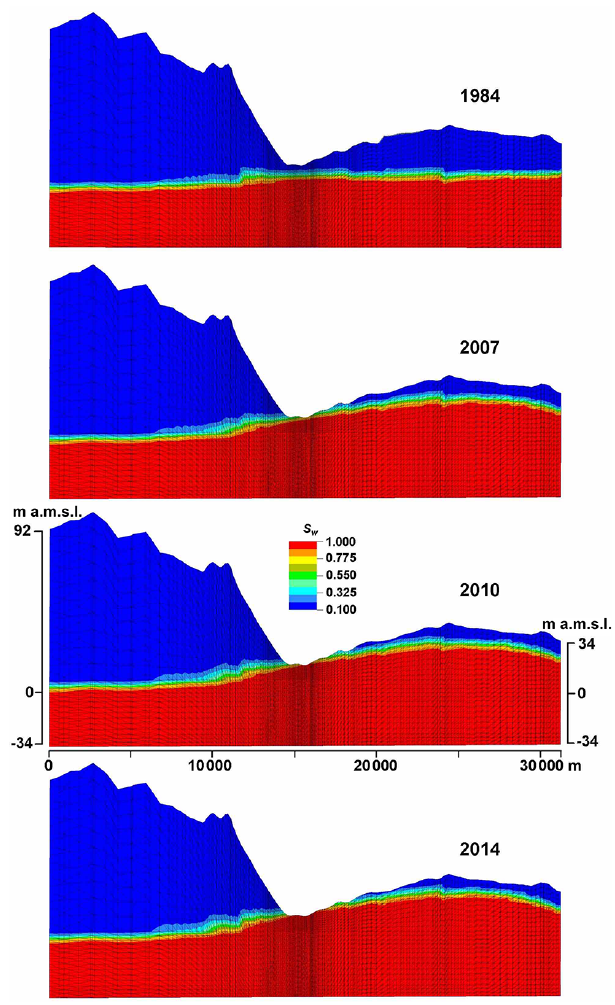
Figure 9. The evolution of the saturation degree along the vertical cross section E–E traced in Fig. 2, i.e., along the main groundwater flow direction as obtained by the 3-D depression-scale